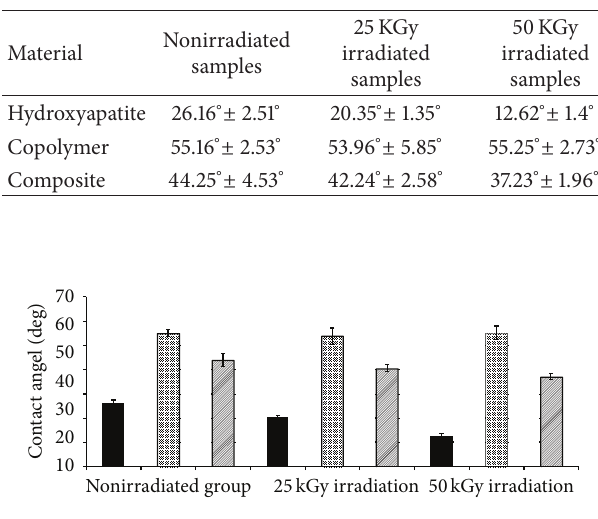
Table 4: Contact angle of hydroxyapatite, copolymers, and compos- ites irradiated with 0, 25, and 50 KGy doses of gamma irradiation.